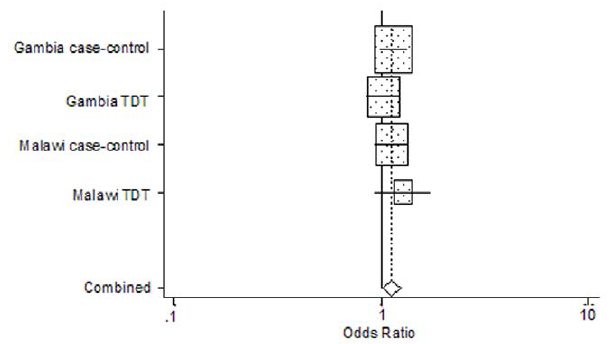
Figure 1. Forest plot of the odds ratios of severe malaria allelic associations at the rs9624472 locus. Odds ratios of severe malaria associations with the rs9624472 G allele are represented for each study as a grey box with a horizontal line. The mid-point of the line represents the odds ratio and the extreme points of the line represent the 95% CI. The contribution of each study to the meta-analysis is represented by the area of the grey box. The solid vertical line presents an odds-ratio of 1 (no association). The diamond at the bottom presents the overall odds ratio and CI: OR=1.22 (95% CI: 1.09–1.37), P=0.001. Cochran’s Q- test for heterogeneity on 4 degrees of freedom: P=0.501.